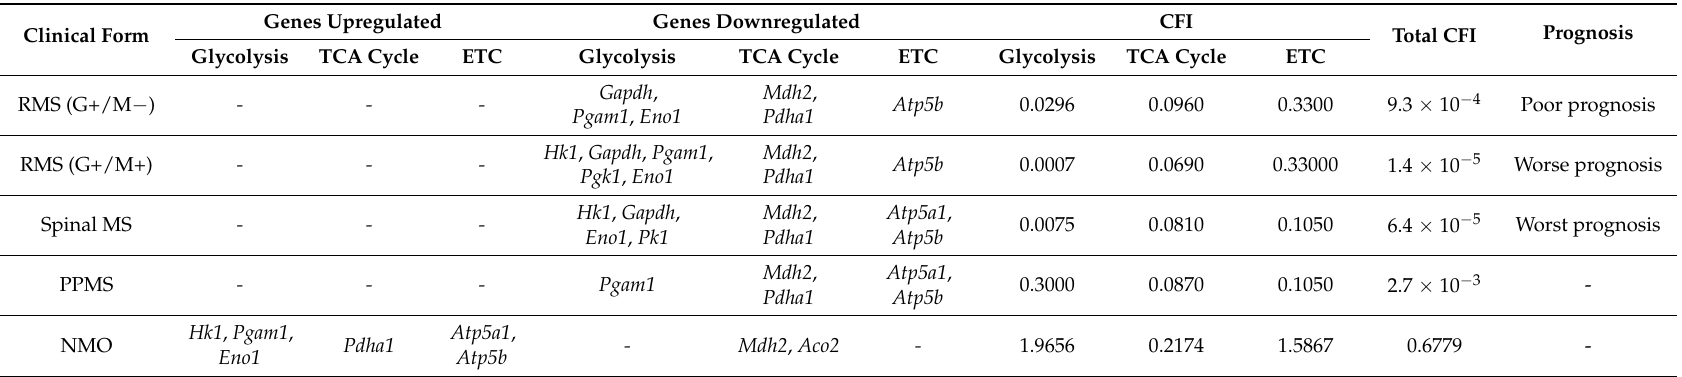
Table 5. Differentially expressed genes, which are upregulated and downregulated in distinct MS clinical forms and NMO and their related cumulative flux